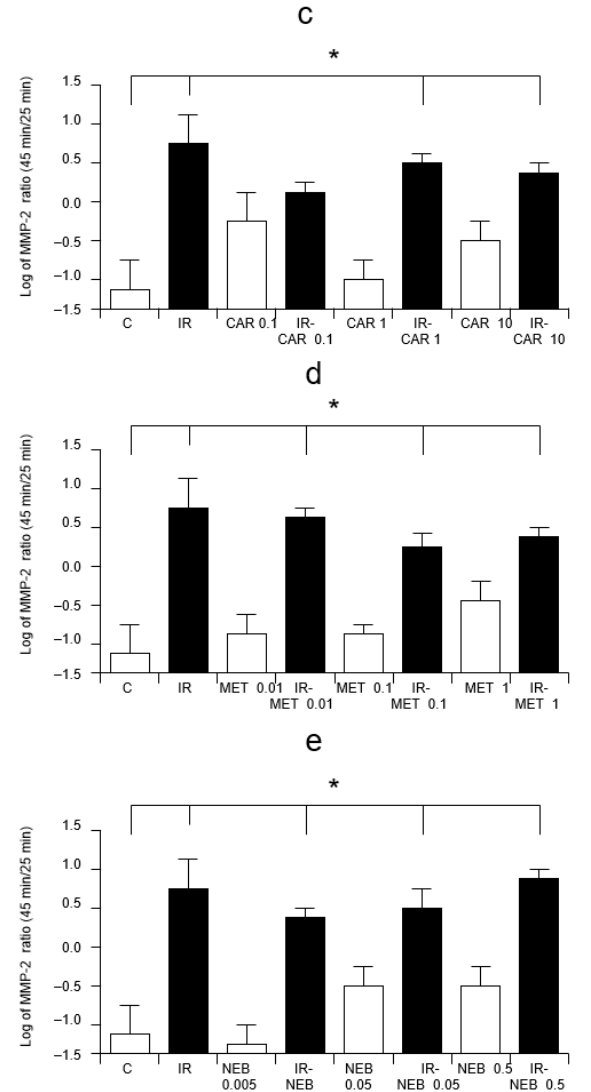
Figure 2. Influence of carvedilol, metoprolol and nebivolol on MMP-2 activity in coronary effluent. ( a ) Densitometric analysis of gelatinolytic MMP-2 activities in coronary effluent in samples from perfused hearts collected at different time points. ( b ) Representative zymogram showing gelatinolytic activities in coronary effluent samples from perfused hearts collected at different time points. The 72 kDa MMP- 2 specific activity in coronary effluent samples was assessed by densitometric analysis ( c ) Log ratio of 45 vs. 25 min perfusion MMP-2 activities in coronary effluent in carvedilol treated groups. ( d ) Log ratio of 45 vs. 25 min perfusion MMP-2 activities in coronary effluent in metoprolol treated groups. ( e ) Log ratio of 45 vs. 25 min perfusion MMP-2 activities in coronary effluent in nebivolol treated groups. Only in the IR CAR 0.01 group there was no significant increase in MMP-2 activity. C—control group, aerobically perfused hearts, IR injury—ischemia-reperfusion injury, IR-CAR 0.1—hearts from IR injury model treated with 0.1 µ M carvedilol, IR-CAR 1—hearts from IR injury model treated with 1 µ M carvedilol, IR-CAR 10—hearts from IR injury model treated with 10 µ M carvedilol, IR-MET 0.01—hearts from IR injury model treated with 0.01 µ M metoprolol, IR-MET 0.1—hearts from IR injury model treated with 0.1 µ M metoprolol, IR-MET 1—hearts from IR injury model treated with 1 µ M metoprolol, IR-NEB 0.005—hearts from IR injury model treated with 0.005 µ M nebivolol, IR-NEB 0.05—hearts from IR injury model treated with 0.05 µ M nebivolol, IR-NEB 0.5—hearts from IR injury model treated with 0.5 µ M nebivolol. * C vs IR, IR-CAR 1, IR-CAR 10, IR-MET 0.01, IR-MET 0.1, IR-MET 1, IR-NEB 0.005, IR-NEB 0.05, IR-NEB 0.5, p < 0.05, n = 6,